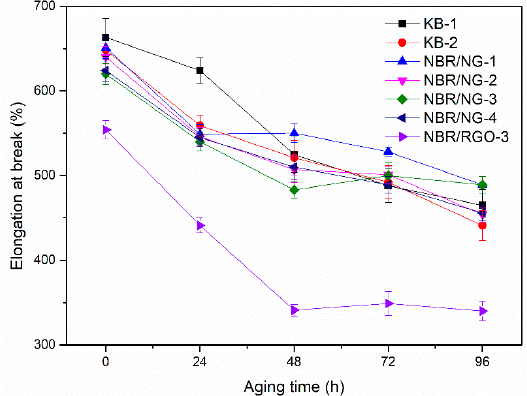
Figure 8. Stress at break of NBR composites at different aging times.